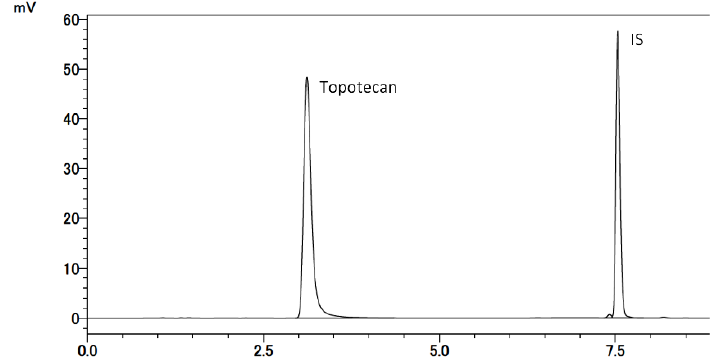
Table 1. Sensitivity, accuracy, and precision of the HPLC method in the measurement of topotecan concentration in human cerebrospinal fluid.